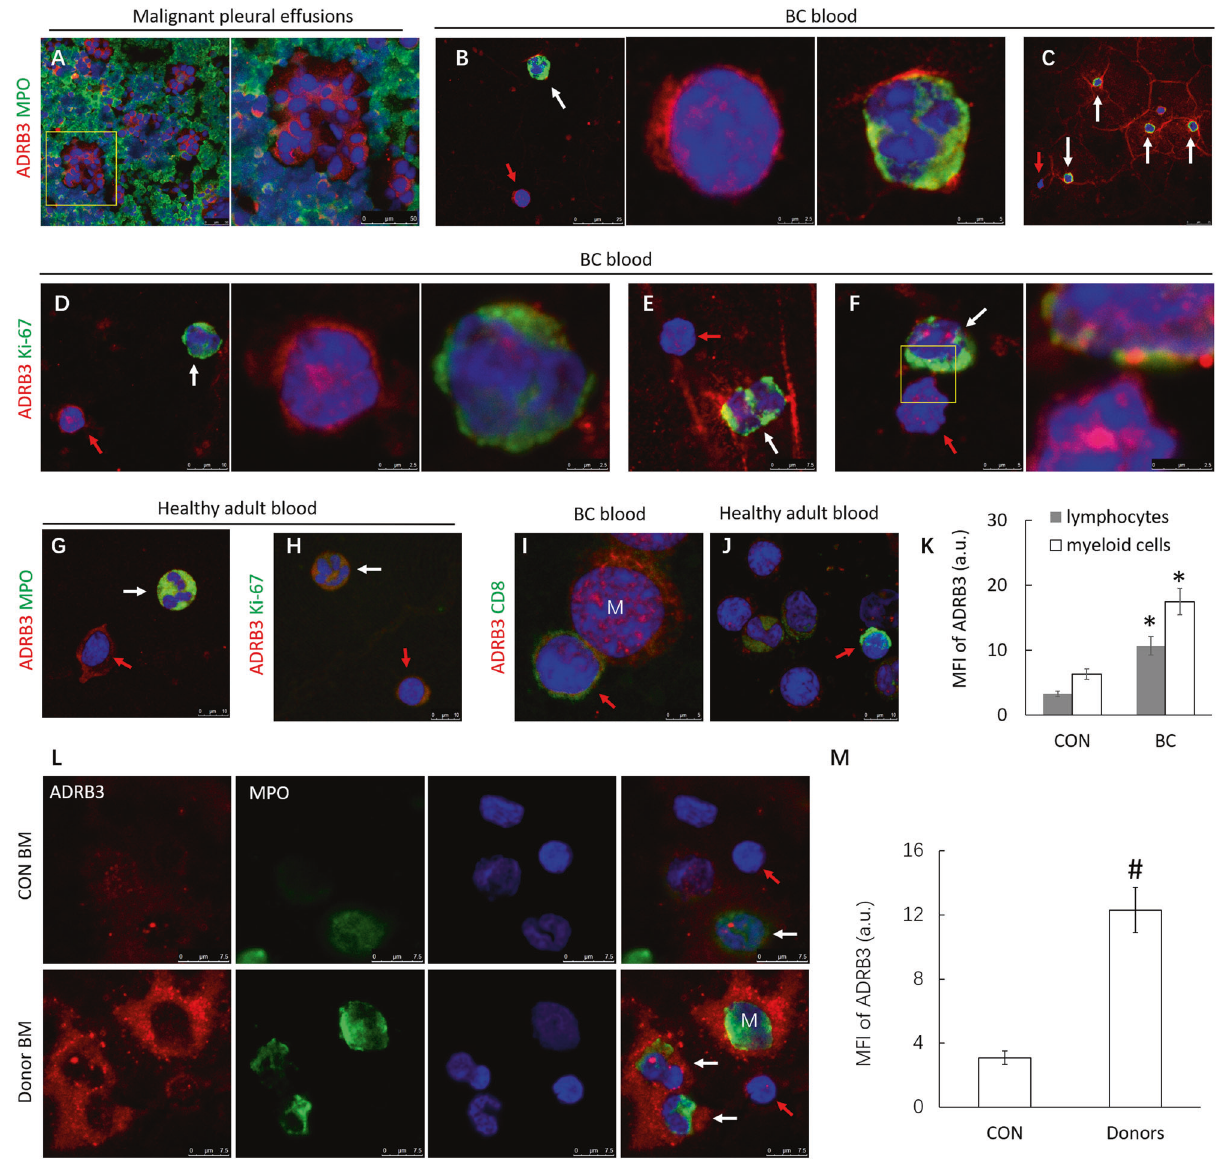
Fig. 2 High ADRB3 expression in DTCs and IMCs of BC patients. A Representative images of immuno fl uorescence results for anti-ADRB3 (red) and anti-MPO (green) staining on MPE smear show that ADRB3 was expressed on myeloid cells (MPO + cells). Confocal images were collected using a 63× oil-immersion lens. B Immuno fl uorescence of ADRB3 (red) and MPO (green) in blood smear of BC patients. Middle and right: Highly magni fi ed view of left. White arrows indicate myeloid cells, red arrows indicate lymphocytes. C Immuno fl uorescence of ADRB3 (red) and MPO (green) on NETs in blood smear of BC patients. White arrows indicate myeloid cells, red arrows indicate lymphocytes. D Immuno fl uorescence of ADRB3 (red) and Ki-67 (green) in blood smear of BC patients. Middle and right: Highly magni fi ed view of left. White arrows indicate myeloid cells, red arrows indicate lymphocytes. E Immuno fl uorescence of ADRB3 (red) and Ki-67 (green) on NETs in blood smear of BC patients. F Immuno fl uorescence of ADRB3 (red) and Ki-67 (green) on adherens junction between lymphocytes and neutrophils in blood smear of BC patients. White arrows indicate myeloid cells, red arrows indicate lymphocytes. G , H Immuno fl uorescence of ADRB3 (red), MPO (green), and Ki-67 (green) in blood smear of healthy controls. White arrows indicate myeloid cells, red arrows indicate lymphocytes. I Immuno fl uorescence of ADRB3 (red) and CD8 (green) in blood smear of BC patients. M: monocyte. Red arrows indicate lymphocytes. J Immuno fl uorescence of ADRB3 (red) and CD8 (green) in blood smear of healthy controls. Red arrows indicate lymphocytes. K Mean fl uorescent intensities (MFI) of ADRB3. Data is expressed as means ± SEM of six independent experiments. * P < 0.05 compared with the healthy controls. L , M Immuno fl uorescence of ADRB3 (red) and MPO (green) in BMC of healthy person ( n = 5) and hematopoietic stem cell transplantation donors ( n = 5). # P < 0.01 compared with the healthy initiated by adding SR (0.1 or 1 μ M) in MCF-7 cells before Cancer cells are undifferentiated because they cannot exit the being exposed to differentiation media containing DMI. SR- cell cycle. Cancer cells may share characteristics with 3T3-L1 treatment promoted their differentiation into adipocytes-like preadipocytes, which undergo growth arrest before adipocyte cells in a dose-dependent manner as measured by Oil Red O differentiation. Therefore, we investigated whether ADRB3 staining (Fig. 3H) associated with decreased ADRB3 expression affected the transdifferentiation of MCF-7 cells into adipocyte- (Fig. 3I). like cells by impairing cell cycle exit. Transdifferentiation was